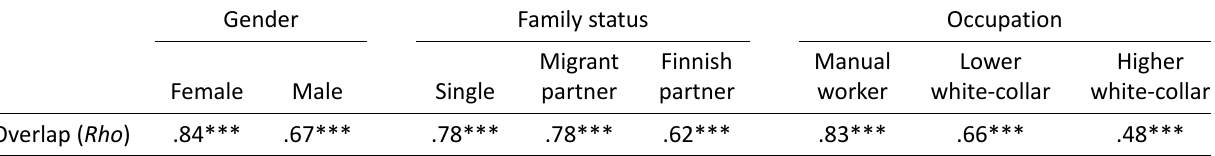
Table 3. GSEM estimates by gender, family status and